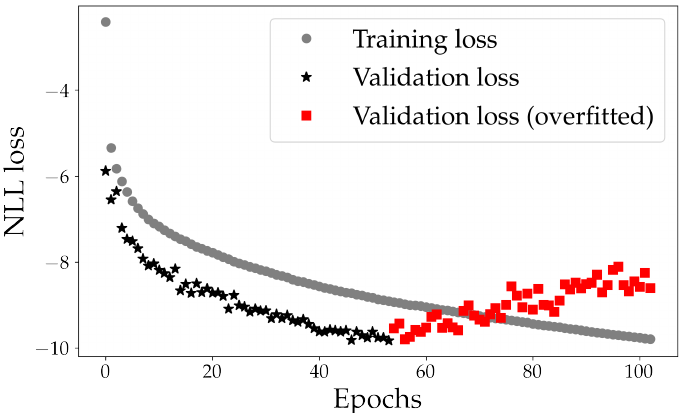
Figure 4. Training and validation negative log likelihood (NLL) loss for the model shown in grey circles and black stars, respectively. The red squares (from validation set) corresponds to when the model starts to overfit the data. The final model is taken from epoch